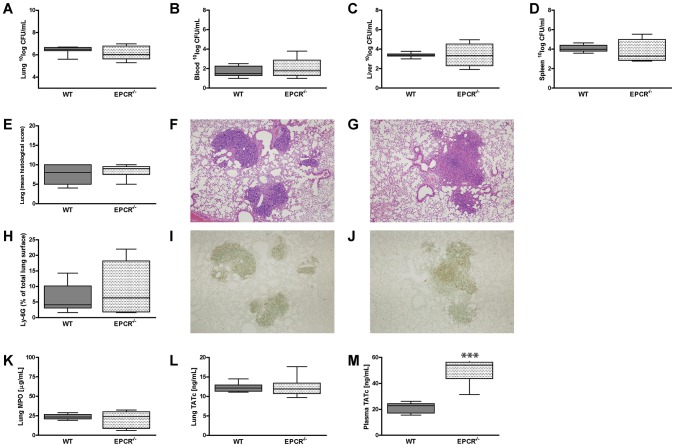
Deficiency of EPCR does not impact on bacterial growth and dissemination, pulmonary damage and neutrophil influx, but does induce coagulation activation in plasma.WT and EPCR-deficient (EPCR−/−) mice were inoculated with 300 CFU of B. pseudomallei and sacrificed after 48 hours. Bacterial loads were counted in lung homogenates (A), blood (B), liver homogenates (C) and spleen homogenates (D). Histopathology scores (E) were assessed as described in the Methods section. Figure F (WT) and G (EPCR−/−) show representative photographs of infected lung tissue 48 hours post-inoculation (H&E staining, original magnification ×100). Neutrophil influx was determined by Ly6G-staining of lung tissue (H). Figure I (WT) and J (EPCR−/−) show representative photographs of lung Ly6G-staining 48 hours post-inoculation (original magnification ×100). Levels of myeloperoxidase (MPO) were measured in lung homogenates (K). Activation of coagulation (TATc) was measured both in lung homogenates (L) and in plasma (M). Data are expressed as box and whisker plots showing the smallest observation, lower quartile, median, upper quartile and largest observation. Grey boxes represent WT mice, white boxes represent EPCR−/− mice (n = 8–9 mice per group for each time point). *P<0.05 for WT versus EPCR−/− mice (Mann-Whitney U test).